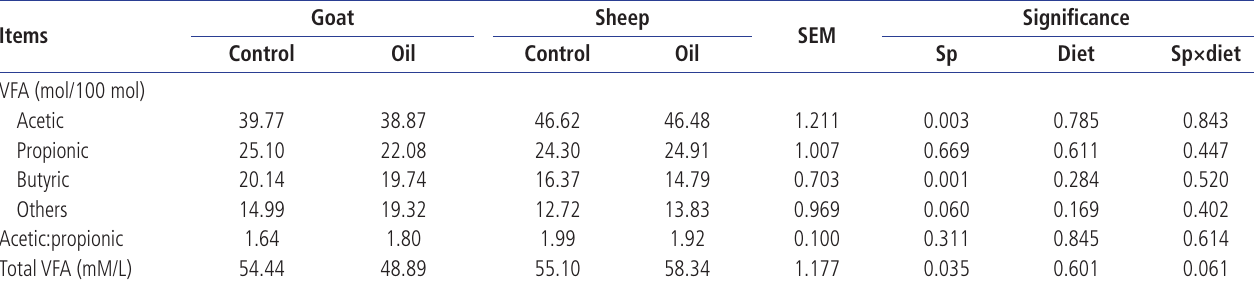
Table 5. Volatile fatty acids content in goat and sheep under different dietary